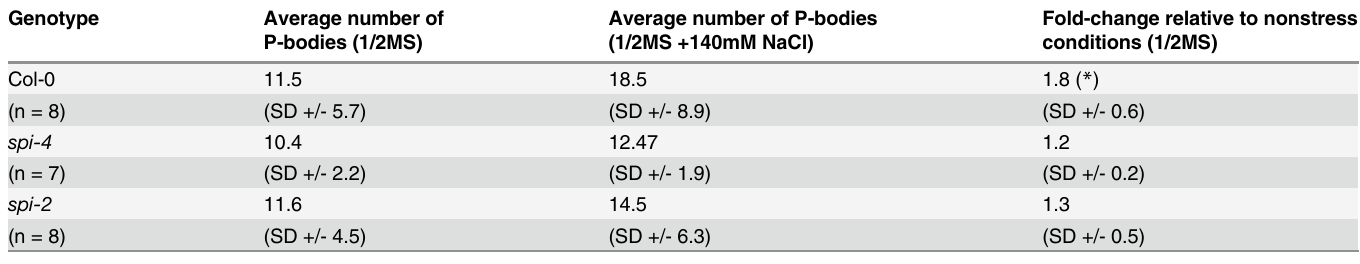
Table 1. P-body number in leaf epidermis cells transiently expressing DCP1-mCHERRY. Average numbers of P-bodies are provided for Col-0, spi-2 and spi-4 under nonstress ( ½ MS) and salt stress ( ½ MS supplemented with 140mM NaCl for 10 h) conditions. Each biological replicate (n) comprises at least 30 cells. SD values represent standard deviations. Two-tailed student ’ s t tests were performed to compare stress and nonstress